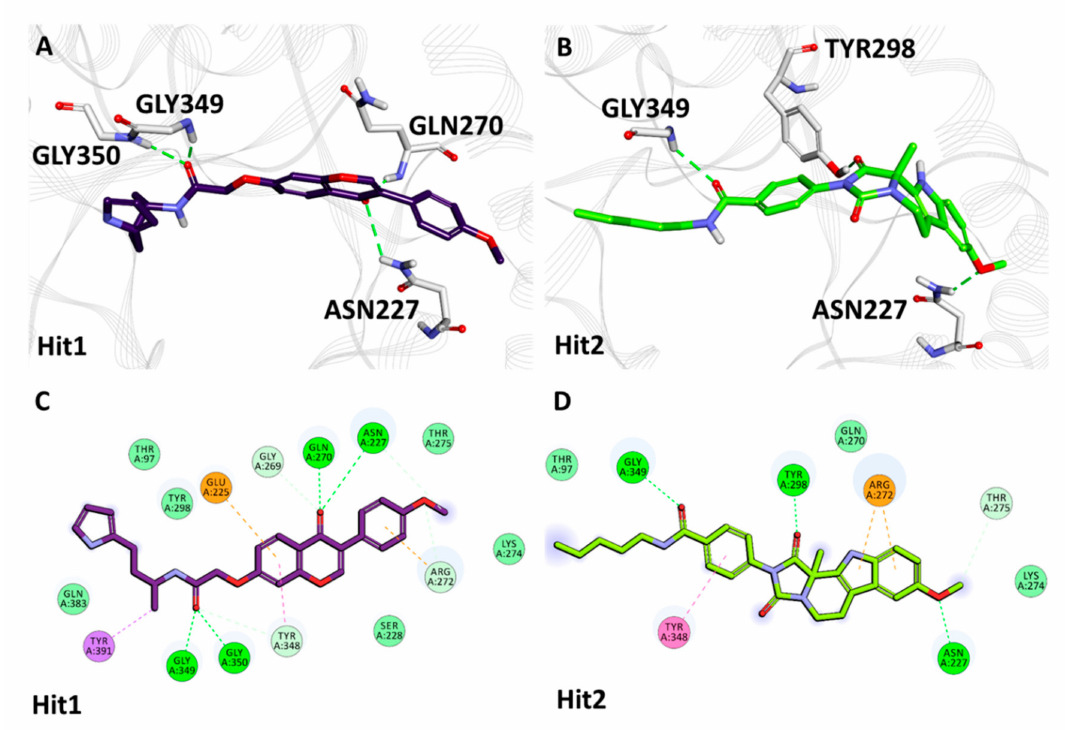
Figure 5. The 3D and 2D intermolecular interactions of natural compound hits (Hit1: A , C ; Hit2: B , D ) with the active site residues of Heparanase.